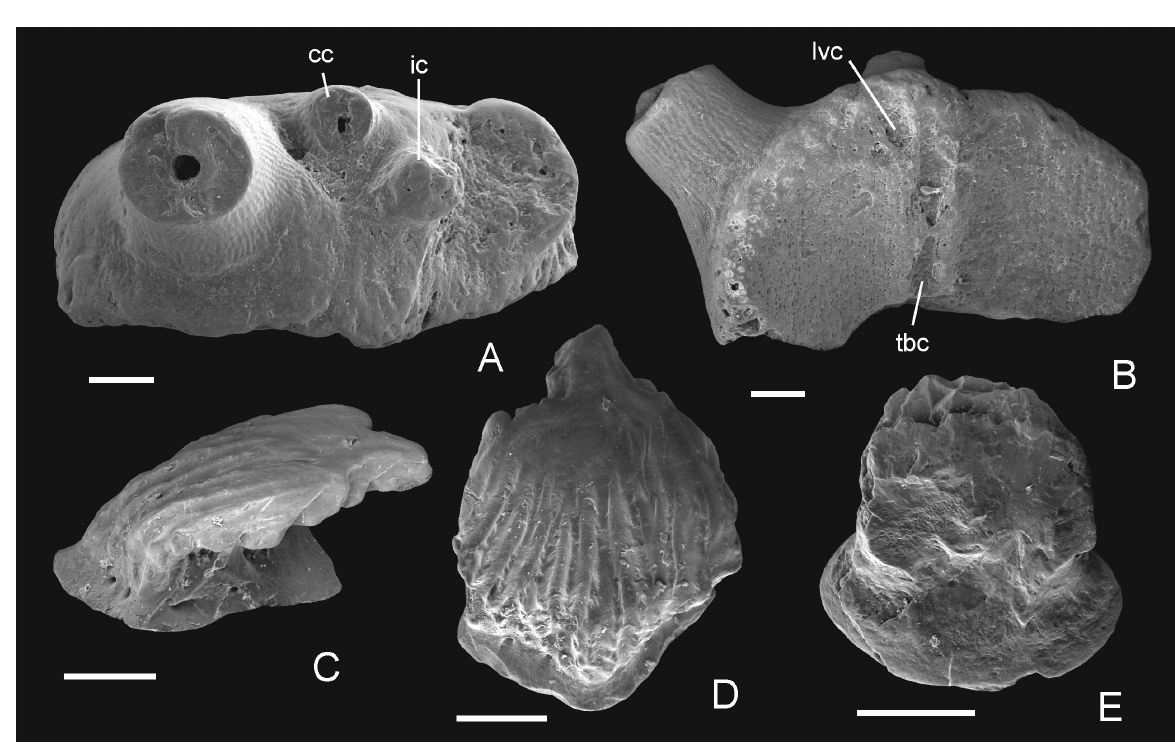
Fig. 3. Chondrichthyan remains from the Burtnieki Regional Stage of the Karksi outcrop, Estonia. A , B , tooth of Karksiodus mirus Ivanov & M(cid:228)rss, 2011; GIT 383-49, sample 02-1, A, occlusal and B, oblique basal views. C (cid:150) E , chondrichthyan scales; C , D , GIT 383-48, sample 02-4; C, lateral and D, crown views; E , GIT 383-47, sample 97, crown view. Scale bars equal 200 (cid:181)m. Abbreviations: cc, central cusp; ic, intermediate cusp; lvc, large vascular canal opening; tbc, transverse basal vascular